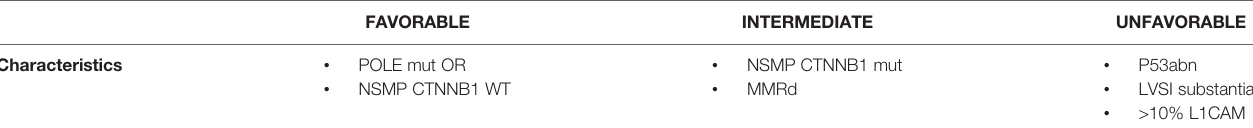
TABLE 2 | Three different prognostic pro fi les in FIGO 2009 Stage I EC, delineated including additional molecular factors.